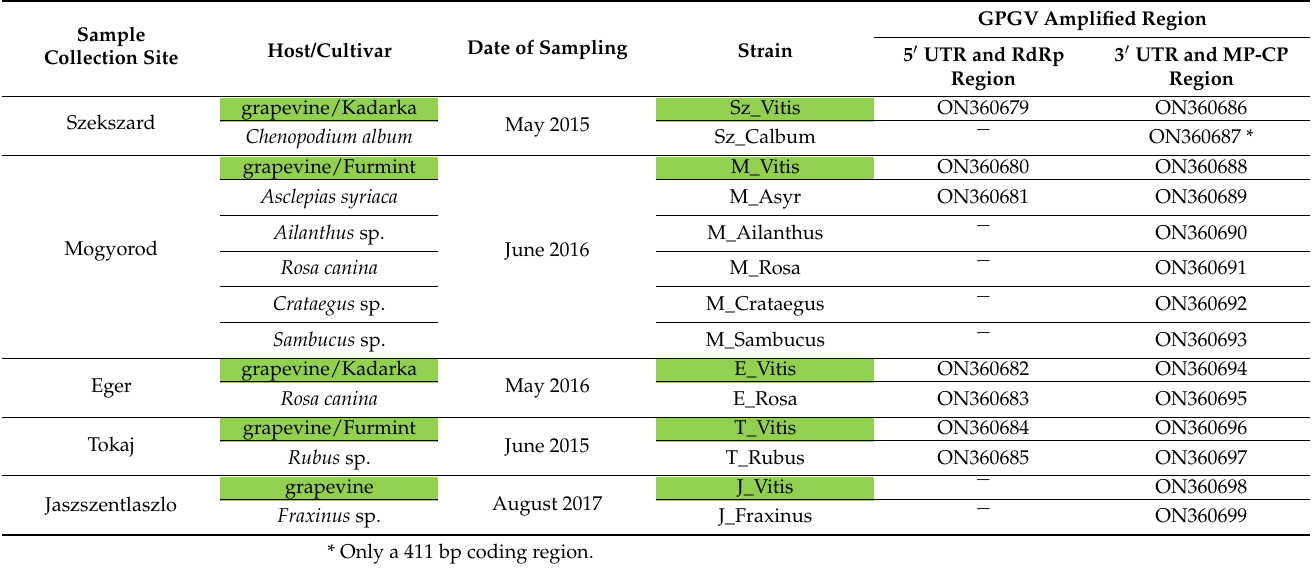
Figure 2. Schematic representation of cloned regions of GPGV, indicating size and position on GPGV genome; 411 bp amplicon was generated using primers described by Glasa et al. [2].